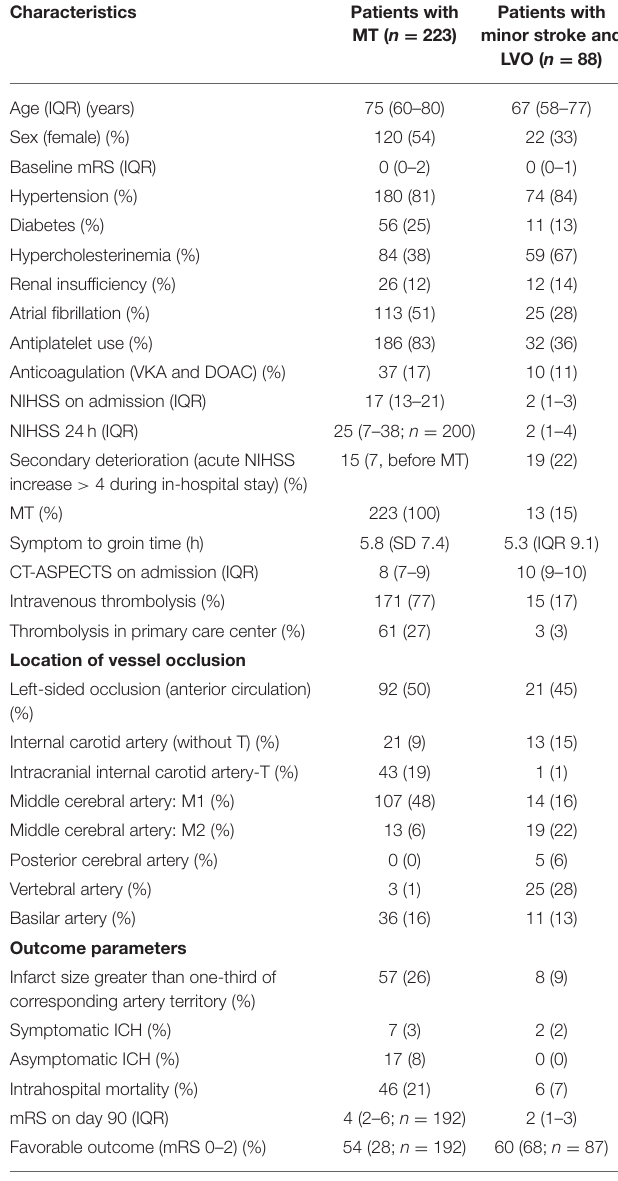
TABLE 1 | Baseline characteristics of included